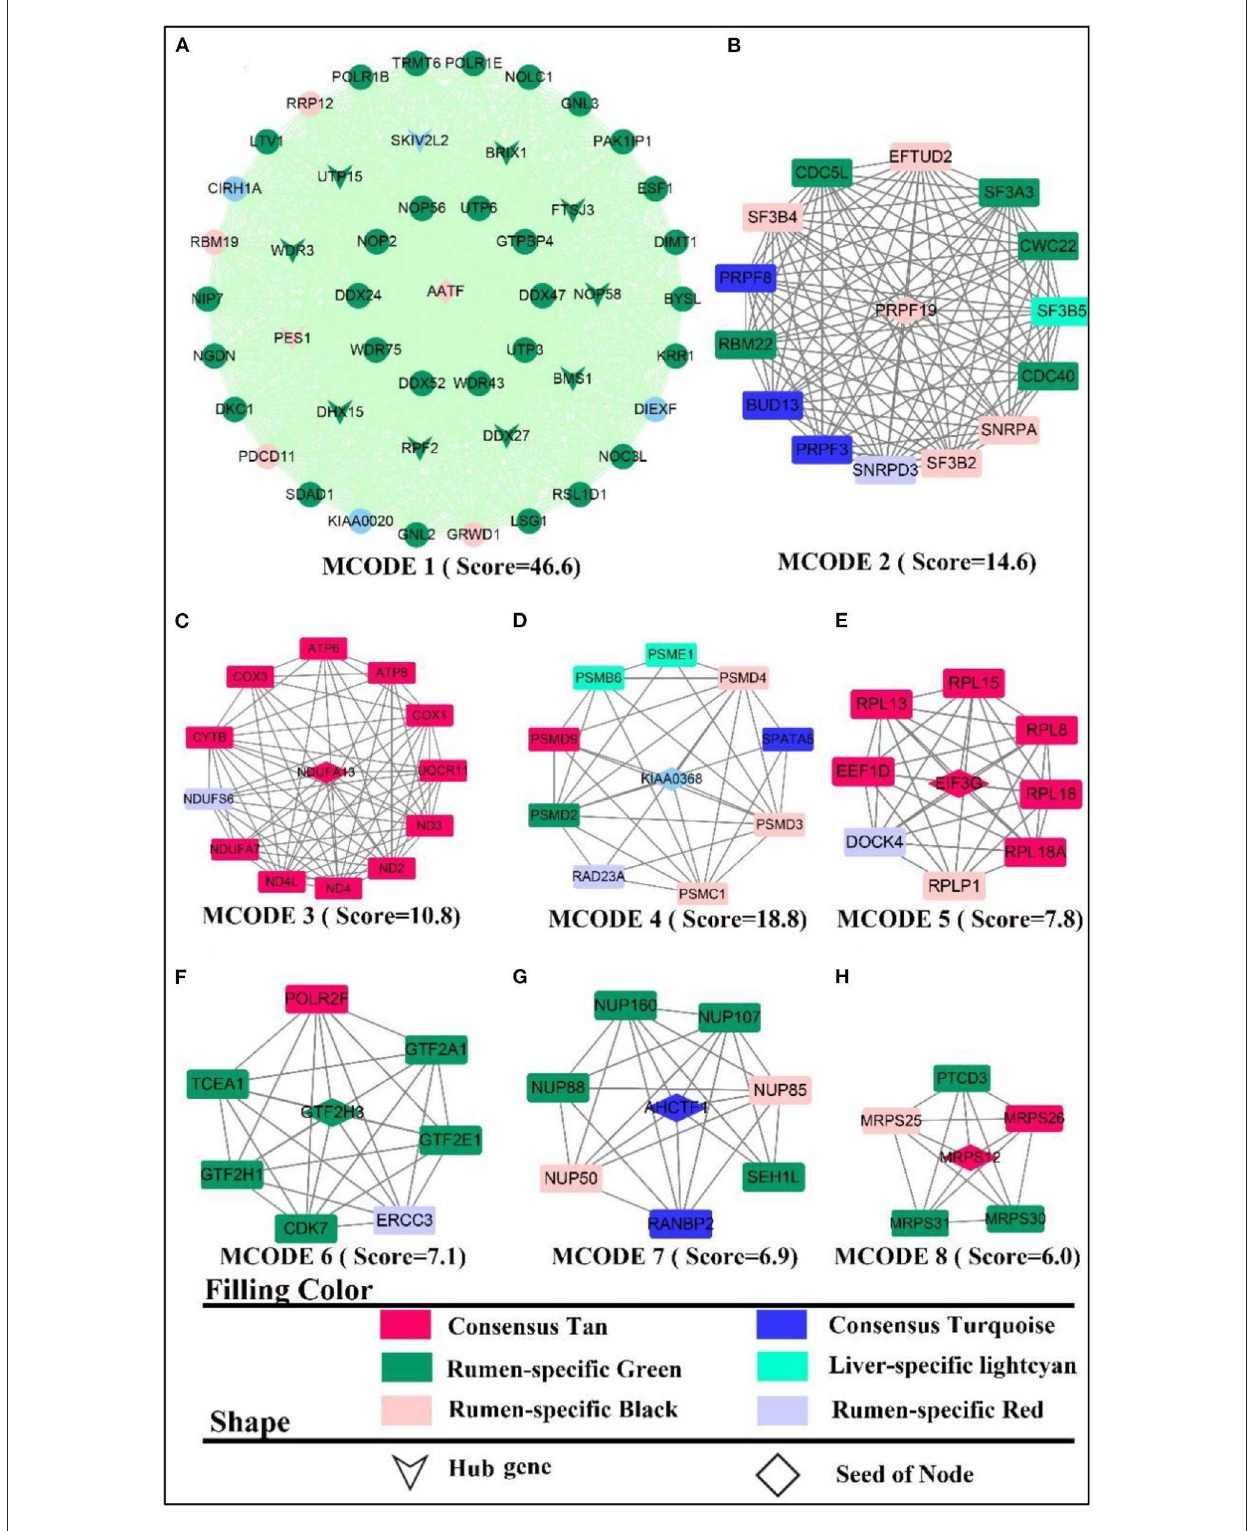
FIGURE3 PPI and hub gene analysis for genes in RL regulatory axis. The color and shape represented gene source and gene type, respectively.